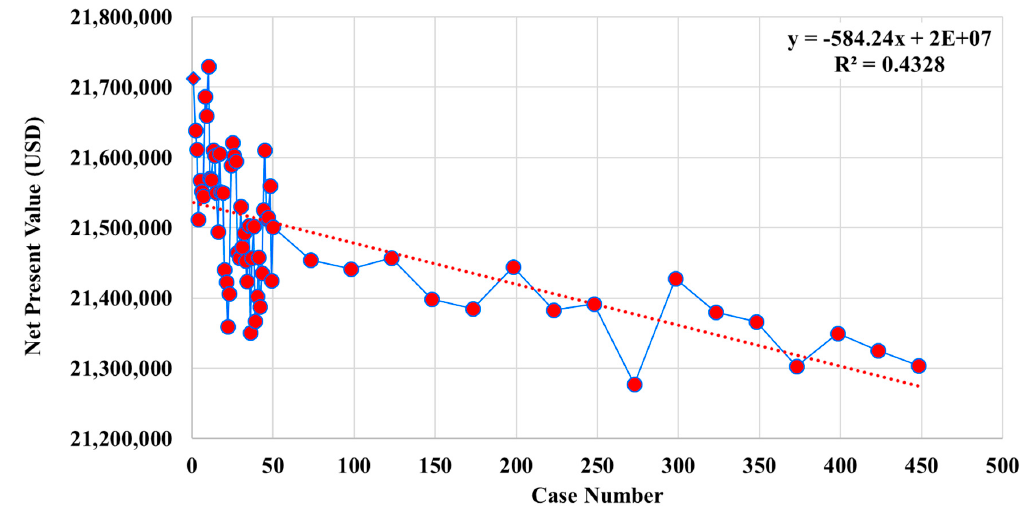
Figure 6. Long-term net present value (NPV) calculations. Figure 6. Long ‐ term net present value (NPV) calculations.